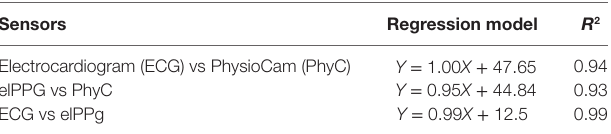
TaBle 2 | Regression model parameters between sensors when measuring interbeat interval.